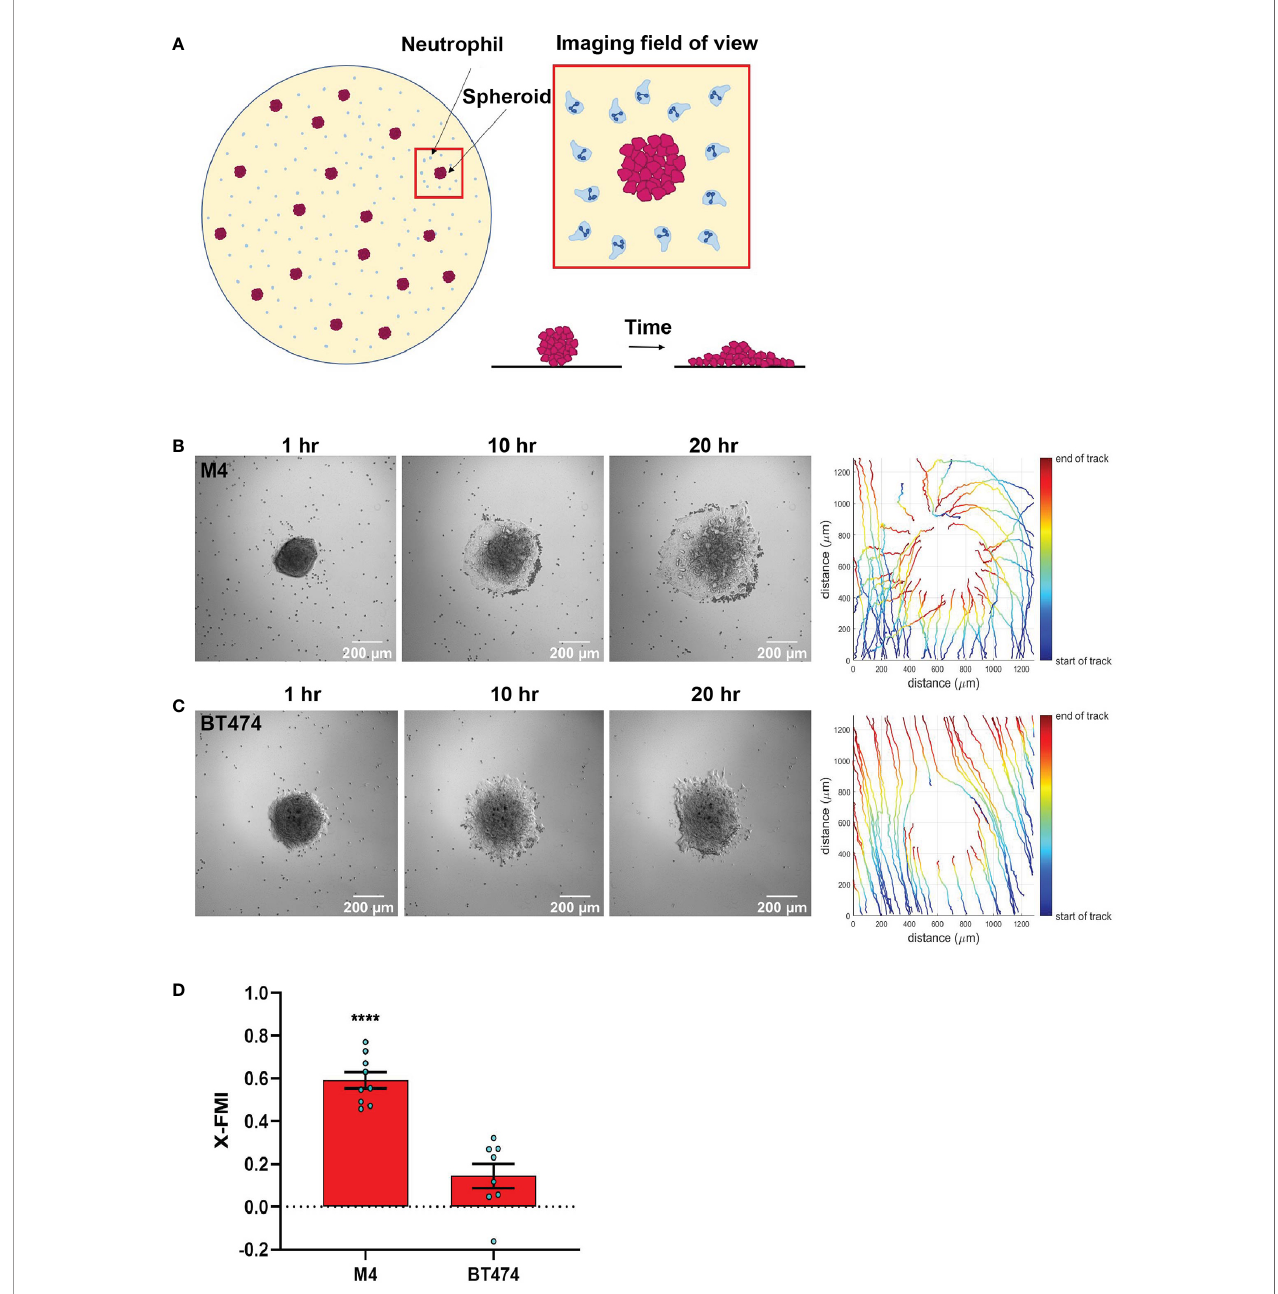
FIGURE 5 | TNBC spheroids actively recruit neutrophils. (A) Cartoon depicting the co-culture migration system used to assess the chemotaxis of neutrophils towards tumor spheroids in fi bronectin coated glass-bottom plate. (B, C) Representative images of a neutrophil-spheroid co-culture migration assay at 1, 10, and 20 hrs with M4 spheroid (B) or BT474 spheroid (C) at the center of the fi eld of view. Small, dark cells are neutrophils from the same donor. Representative tracks of neutrophils are on the right. (D) Graph depicting the X-FMI of neutrophils migrating towards M4 or BT474 spheroids. Each bar represents mean ± SEM from N= 3 (BT474 spheroid) or 4 (M4 spheroid) independent donors with each dot representing the average X-FMI for all neutrophils tracked per spheroid. An average of 45 neutrophils were tracked per spheroid. ****P < 0.0001 when compared with BT474 (unpaired